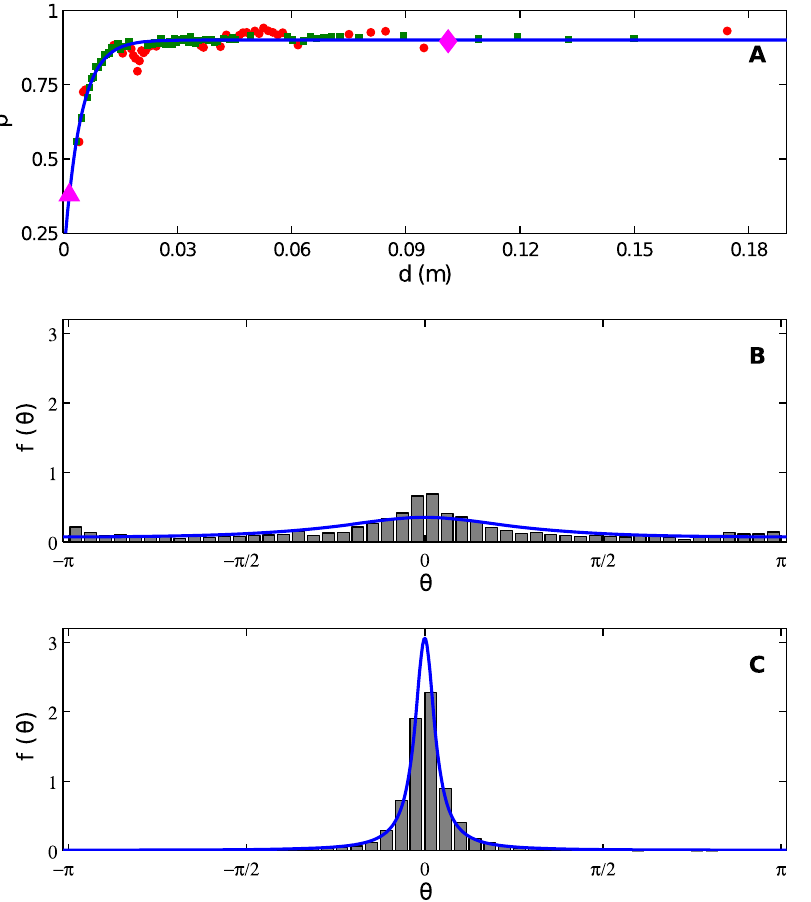
Figure 4. Correlated random walk turning angle h . (A) Turning angle distribution parameter 0 , r , 1 as a function of distance to an aphid’s nearest neighbor. Here, r is a parameter in the zero-mean wrapped Cauchy distribution Eq. (6) used to model turning angle h . Each data point represents the experimentally measured value of r within a bin of 2400 elements from our experimental data set, where the data are binned by d . The overall dependence of the data on d is modeled with Eq. (7), which captures the tendency of aphids to aggregate by taking wider turns when in the vicinity of others, leading to motion that is more diffusive and less ballistic. Best fit parameters appear in the text; the coefficient of determination is R 2 =0.99. Green circles (red dots) points represent data bins for which the model prediction falls within (outside) a 95% confidence interval around the experimentally measured r , where the interval is constructed by resampling our original data 20,000 times. (B) Normalized histogram showing the experimental turning angle distribution within the data bin corresponding to the magenta triangle in (A). The blue curve shows the wrapped Cauchy distribution predicted by our model. (C) Like (B), but for the magenta diamond.